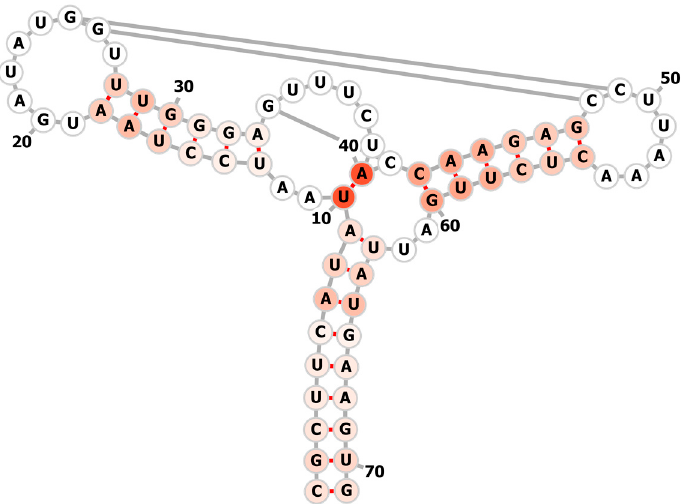
Figure 7. The learned fastest folding path of 1Y26. The darker the color, the earlier the base pairing will be formed.